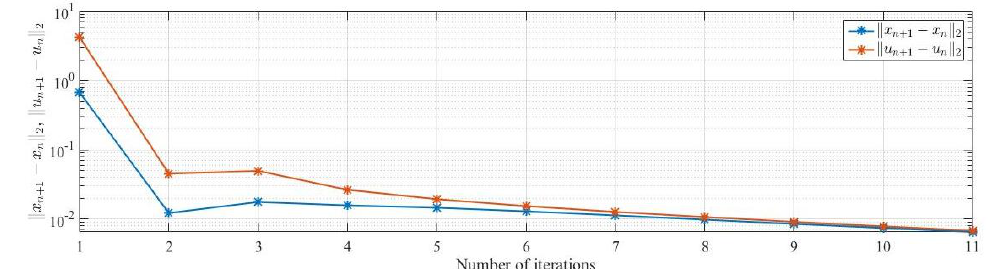
Figure 1. Example 1, case I.